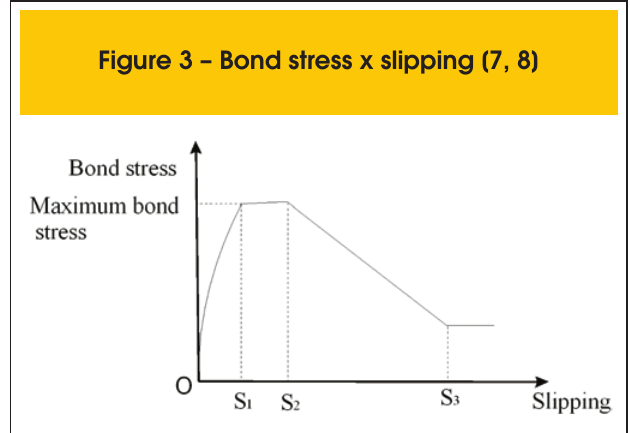
Figure 2 – Representation of the radial component of the bond strength in the anchorage zone (adapted from [3])